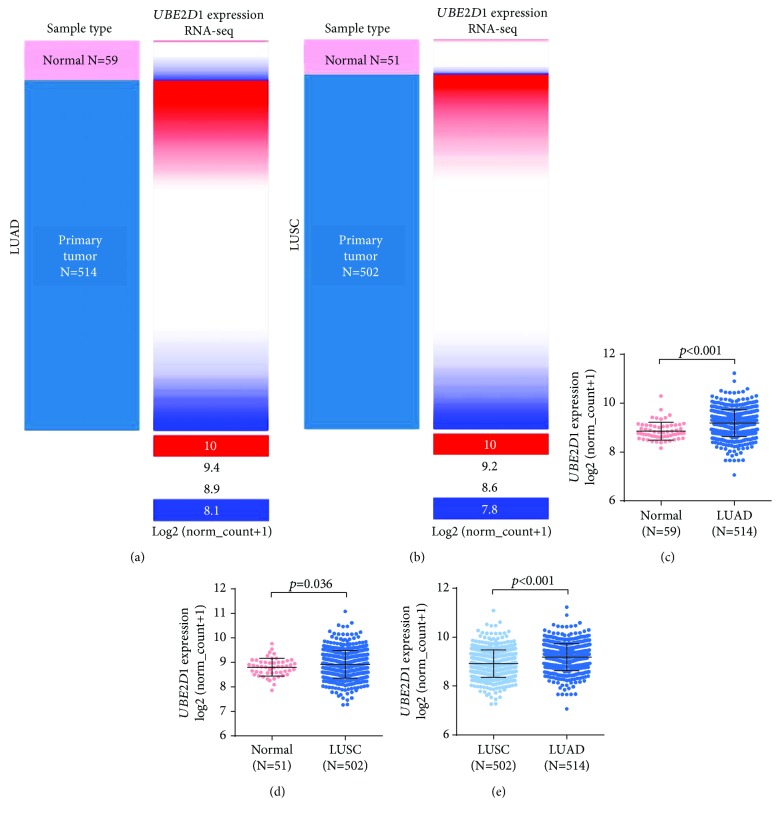

UBE2D1 RNA expression was upregulated in both LUAD and LUSC tissues compared to normal lung tissues (a–d). Heatmap (a–b) and plot chart (b–c) of UBE2D1 RNA expression in LUAD (N = 514) and LUSC (N = 502) tissues and their corresponding normal lung tissues. (e) Comparison of UBE2D1 RNA expression between LUAD and LUSC tissues.